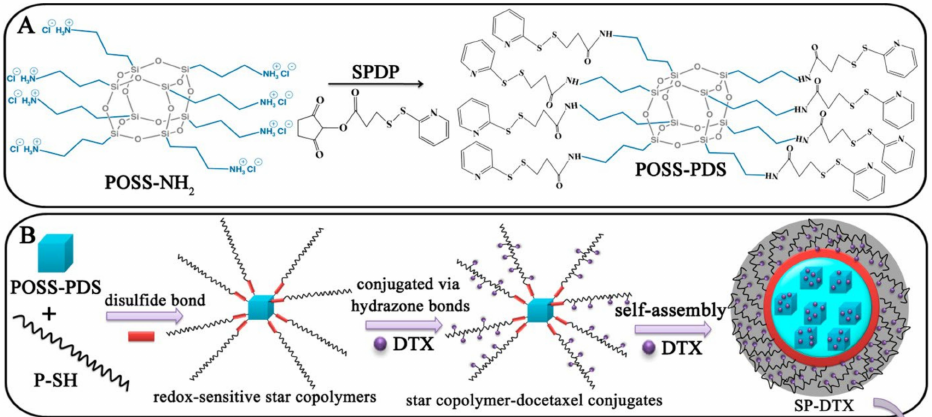
Figure 1. ( A ) Synthesis procedure of pyridyldisulfanyl-functionalized POSS (POSS − PDS). ( B )